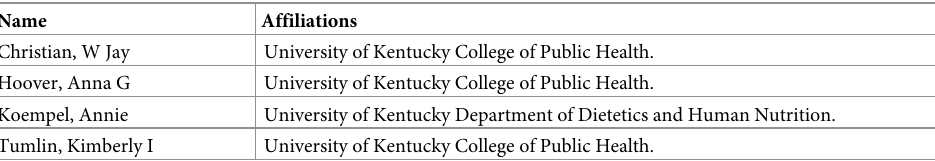
Table 5. Contents of the output collaborator report as a table.